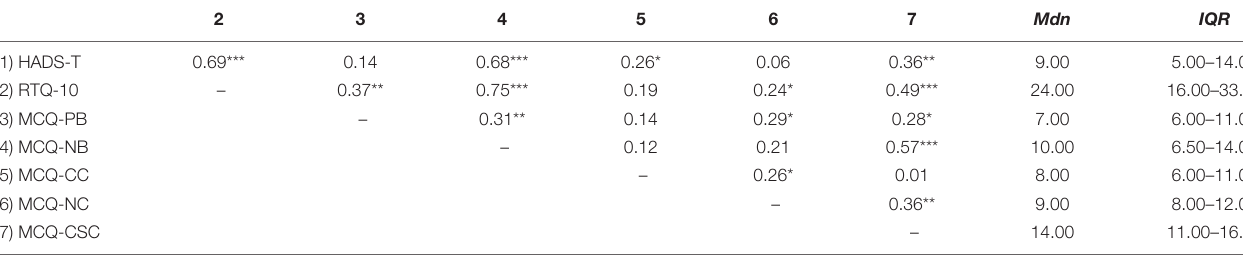
TABLE 2 | Descriptive statistics and Spearman’s rho correlations between study variables.